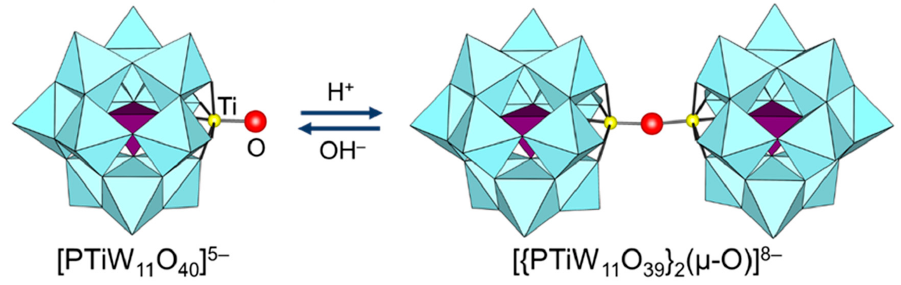
Figure 8. Reversible change between [PTiW 11 O 40 ] 5 − and [{PTiW 11 O 39 } 2 ( μ -O)] 8 − [102] .